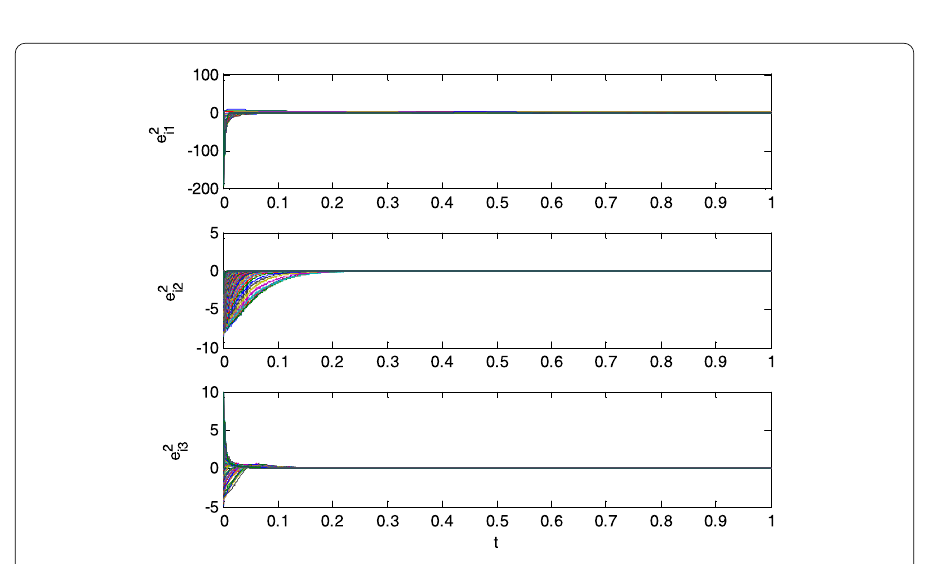
Figure 4 Trajectories of the error system (8) about G 2